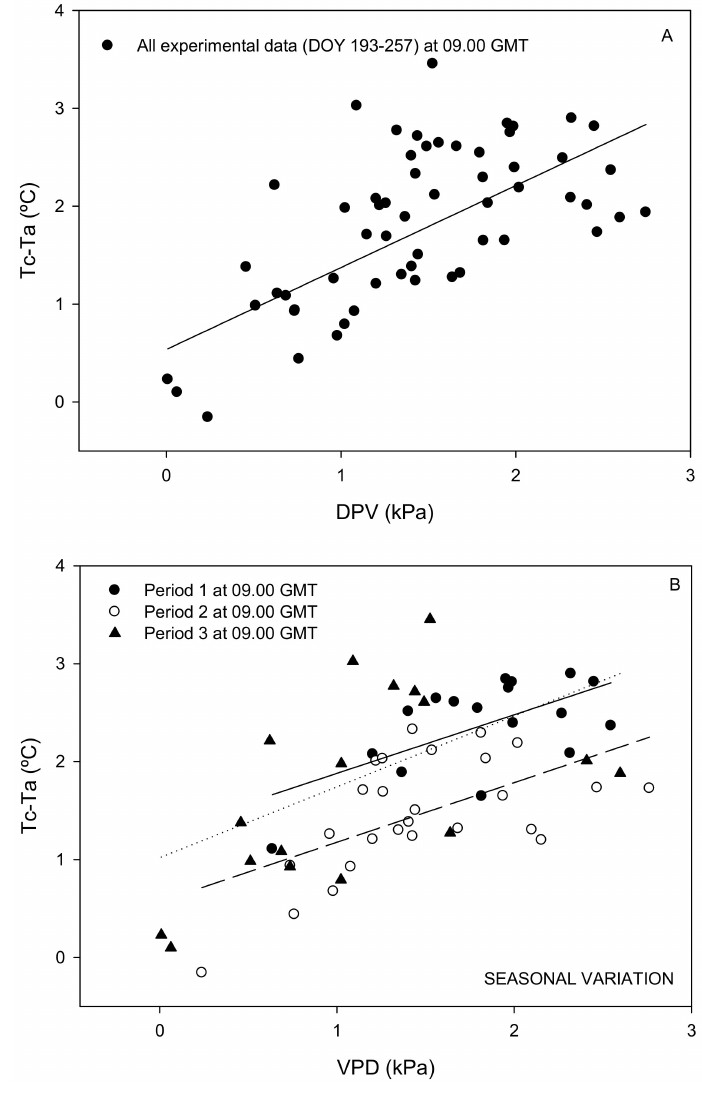
Figure 4. Seasonal variation of non-water stress baselines (NWSBs). Relationships between Tc-Ta (C ◦ ) and VPD (kPa) with ( A ) data from the experimental period (DOY 193-257) plotted together at 09.00 GMT and ( B ) data split into three different periods: 1 (P1, DOY 193-212), 2 (P2, DOY 213-239), and 3 (P3, DOY 240-257). Only clear-sky and non-rainy days were used in the calculations. The linear regressions are shown in Tables 2 and 3. The solid line, long dash line, and dotted line correspond to linear regressions for P1, P2, and P3,